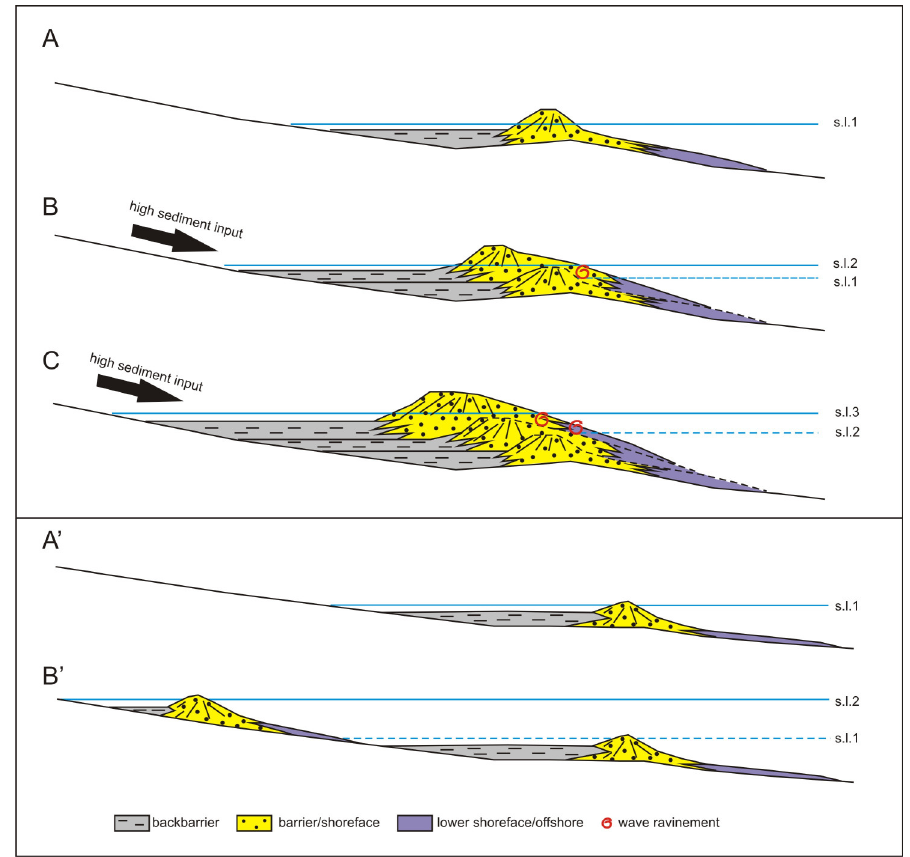
Figure 17. Comparison between our observed “continuous” landward backstepping pattern ( A – C ) and the model of backstepping of Sanders and Kumar [75] and Rampino and Sanders [76] ( A’ – B’ ).